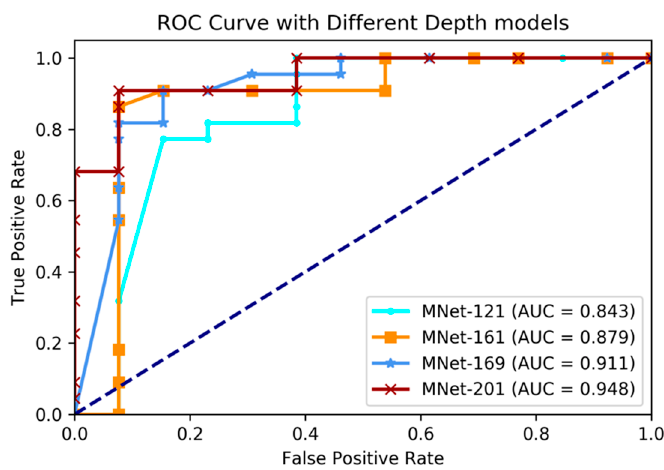
Figure 6. Comparing ROC curve of different depth layer models on World Health Organization (WHO) grade prediction experiments.